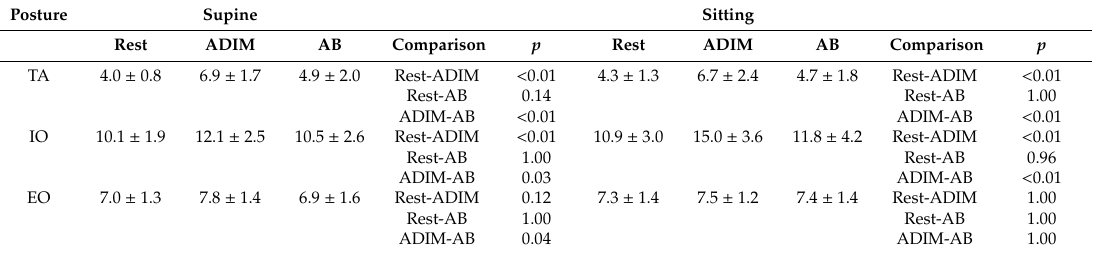
Table 3. Thickness of the abdominal muscles (mm).